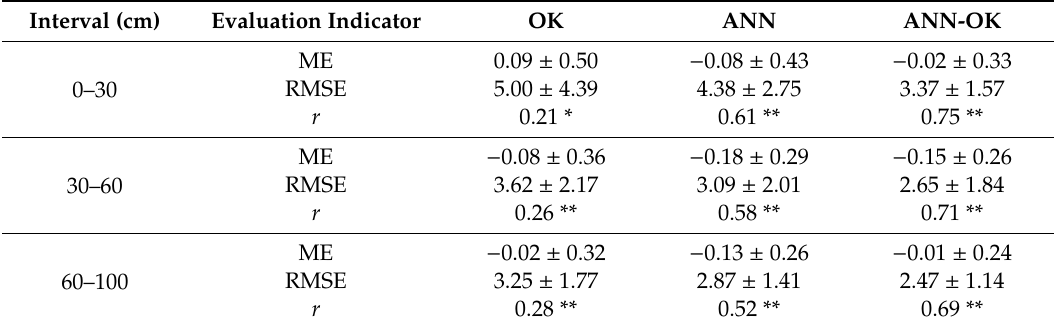
Table 5. Accuracy assessment indicators for the di ff erent methods predicting wetland SOCc (means ± standard deviation). Interval